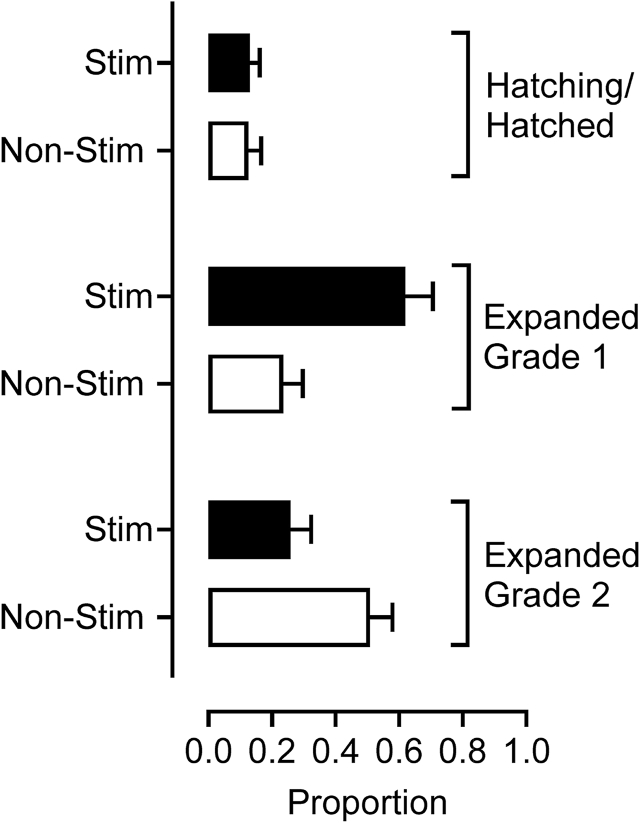
Incidence of aneuploidy in Day 8 blastocysts from stimulated (n = 82 blastocysts) and non-stimulated (n = 70 blastocysts) cycles of OPU. Data represent proportion aneuploid Grade 1 hatched/hatching blastocysts, and Grade 1 and 2 expanded blastocysts. The proportion aneuploid was less (P < 0.01) for Stage 8/9 (hatching/hatched) blastocysts compared to Stage 7 (expanded) blastocysts. However, there was an interaction (P < 0.05) between ovarian-stimulation treatment and blastocyst stage/grade. Aneuploidy decreased as stage/grade improved for blastocysts from non-stimulated cycles but was greatest for expanded Grade 1 blastocysts from stimulated cycles.